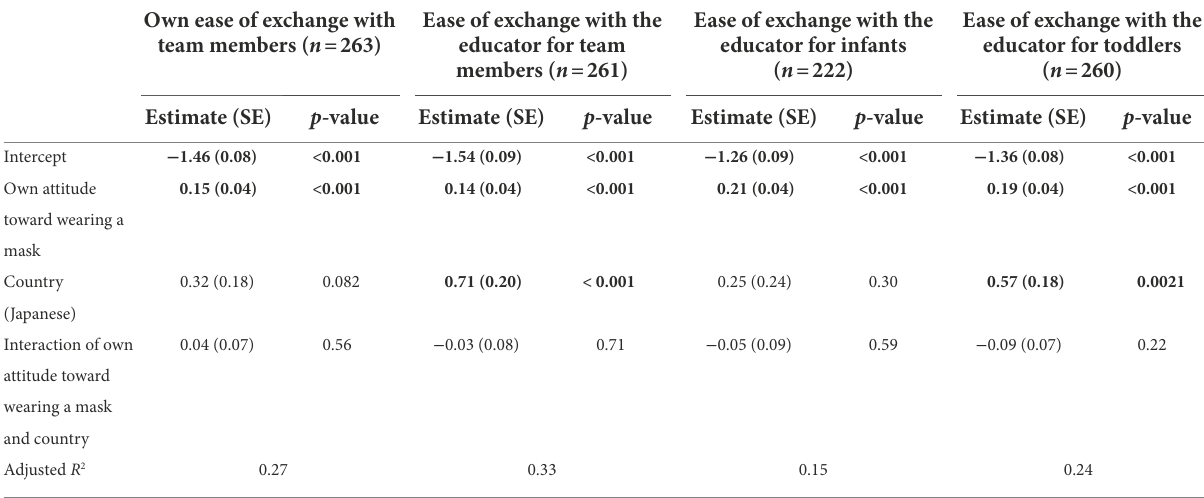
TABLE 12 The linear regression models predicting ease of exchange.